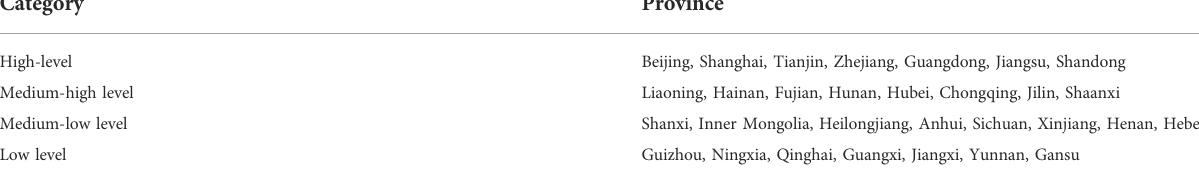
TABLE 4 Economic development quality distribution of Chinese